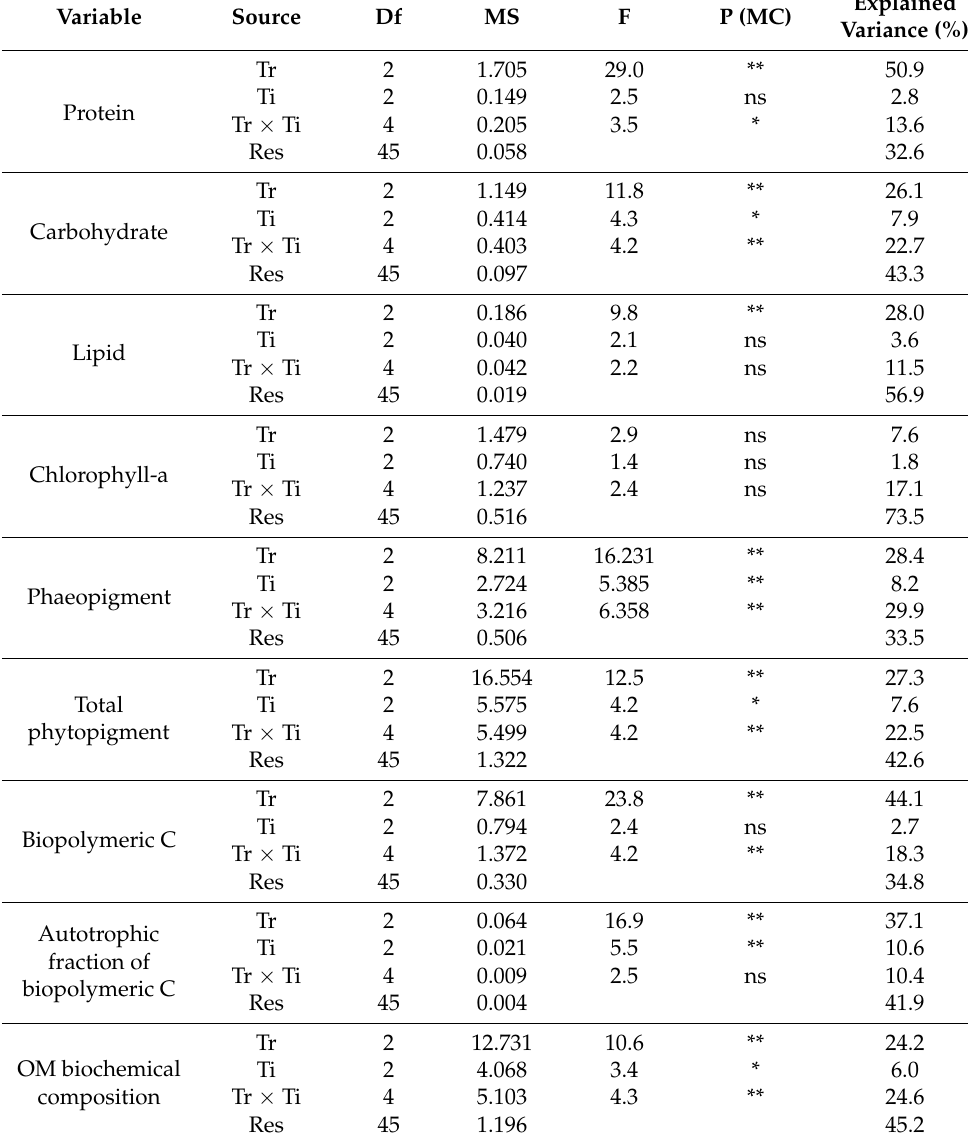
Table 1. Results of PERMANOVA testing for differences in sedimentary organic matter contents and biochemical composition among treatments (Tr: CTRL, MT and HT) and sampling times (Ti: T 0 , T 1 and T 2 ). Df = degrees of freedom; MS = mean square; F = statistic F; ** = p < 0.01; * = p < 0.05; ns = not significant. Reported is also the percentage of variation explained by each factor, their interaction and residual (Res; unexplained) variance. P (MC) = probability level after Monte Carlo simulations and 999